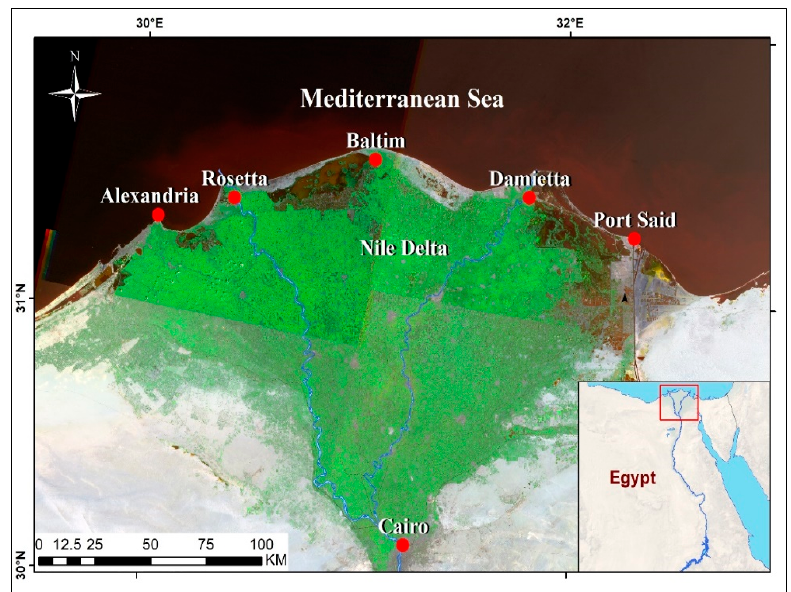
Figure 1. Location map of the study area.